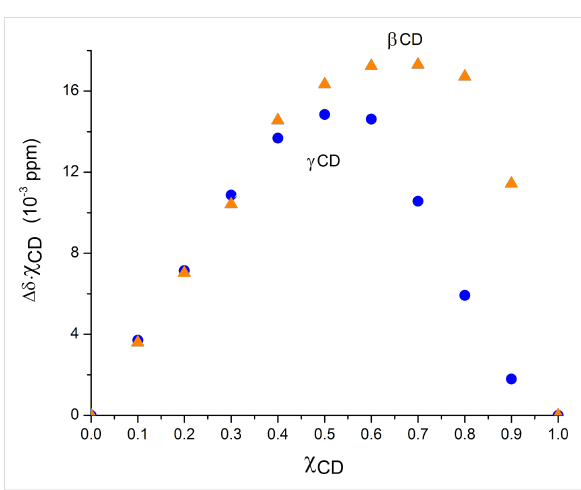
Figure 3: Job plot for the aescin complexes with β -CD (orange trian- gles) and γ -CD (blue dots) in D 2 O.